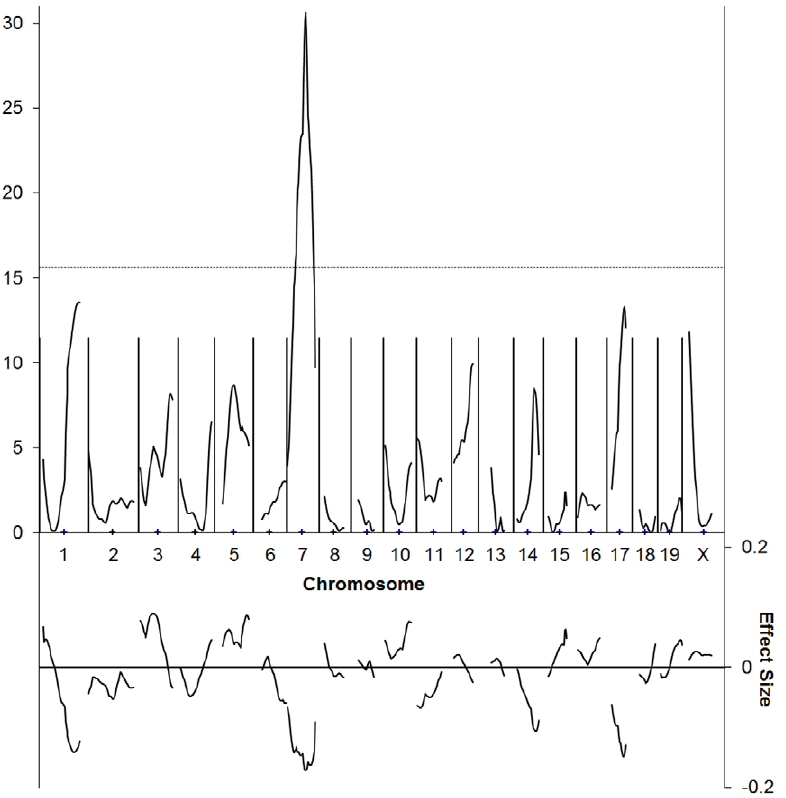
Figure 4. C57BL/6J 6 SJL/J F2 cross simple interval mapping. Whole genome simple interval map. Top: likelihood ratio statistic or likelihood of a region being linked to bFGF-induced corneal neovascularization. Dashed line indicates P=0.05 as determined by bootstrapping. Bottom: predicted additive effect of a region on bFGF-induced corneal neovascularization.